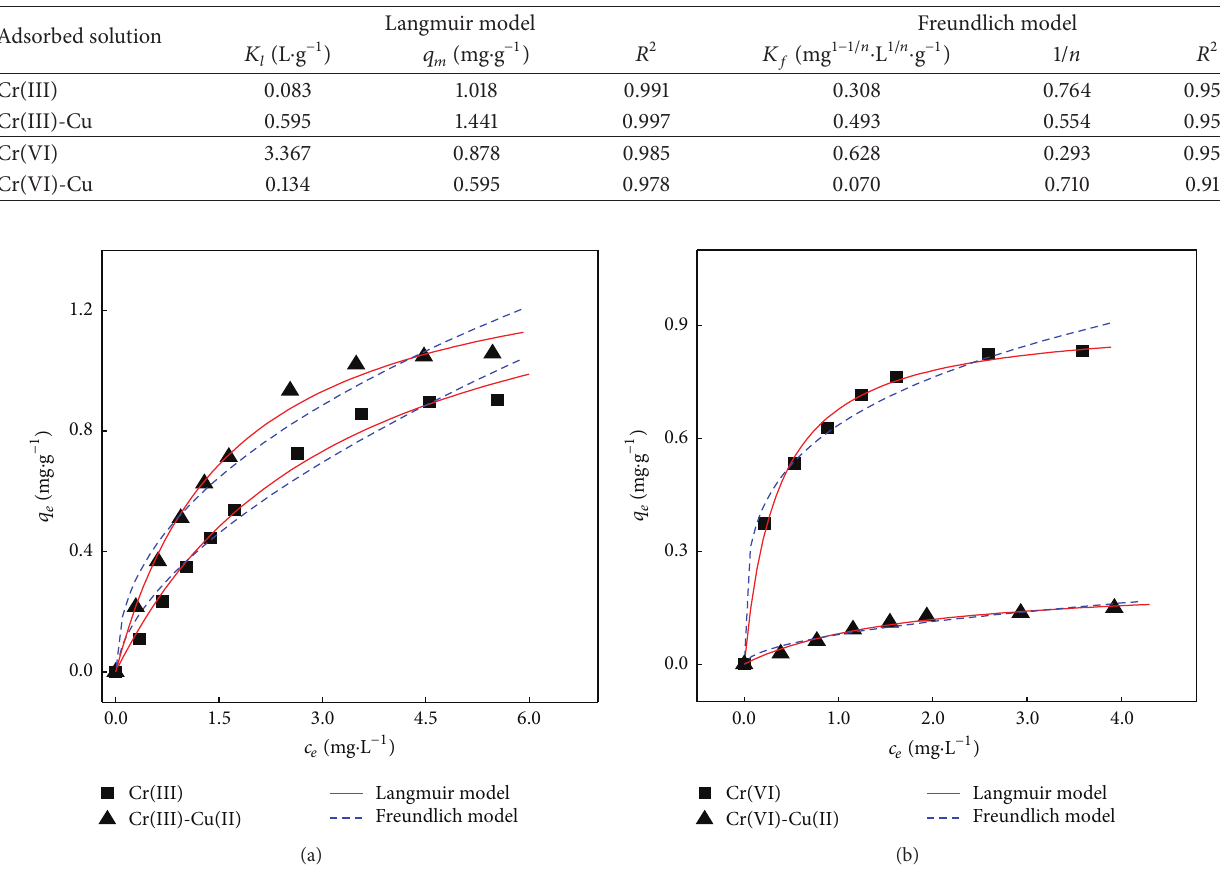
Figure 3: Isotherm plots for Cr(III) (a) or Cr(VI) (b) adsorption by kaolin in single and binary solutions at the fitting of Langmuir and